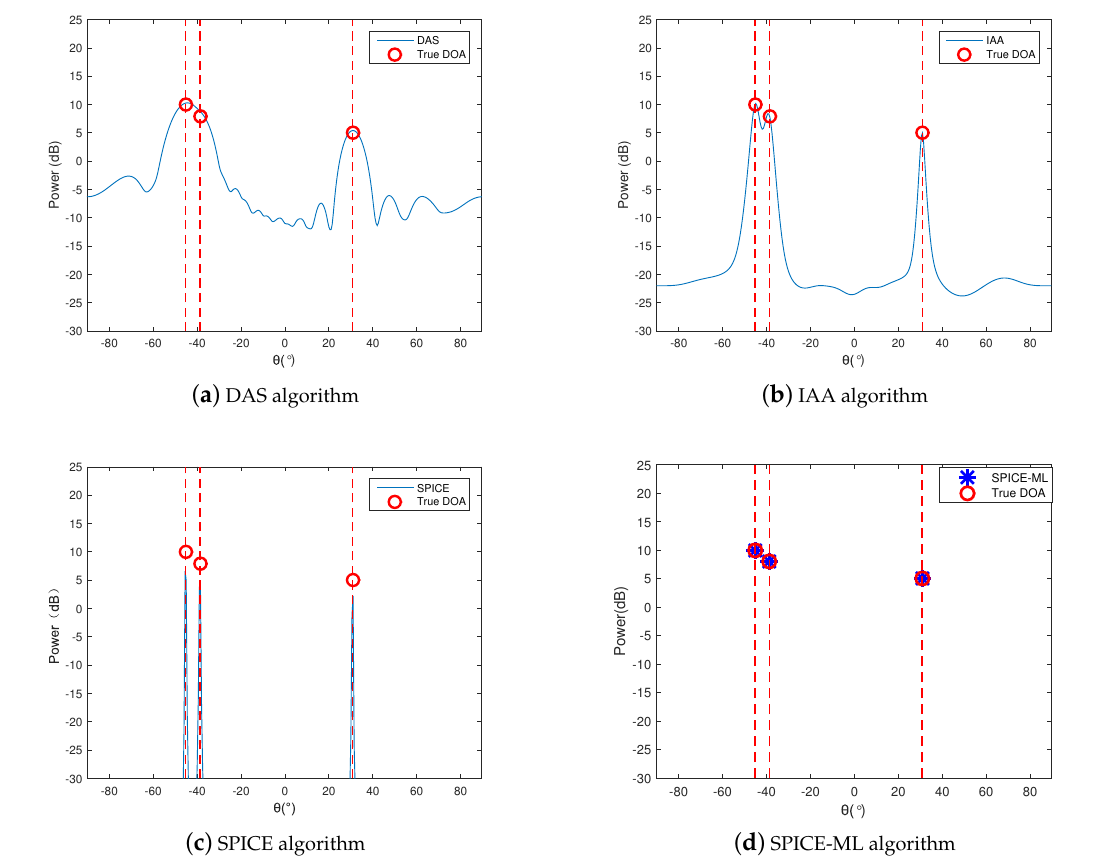
Figure 2. Root mean square error (RMSE) with independent